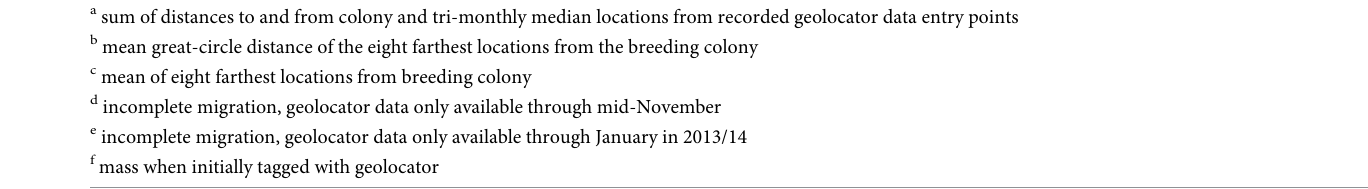
mean great-circle distance of the eight farthest locations from the breeding colony c mean of eight farthest locations from breeding colony d incomplete migration, geolocator data only available through mid-November e incomplete migration, geolocator data only available through January in 2013/14 f mass when initially tagged with